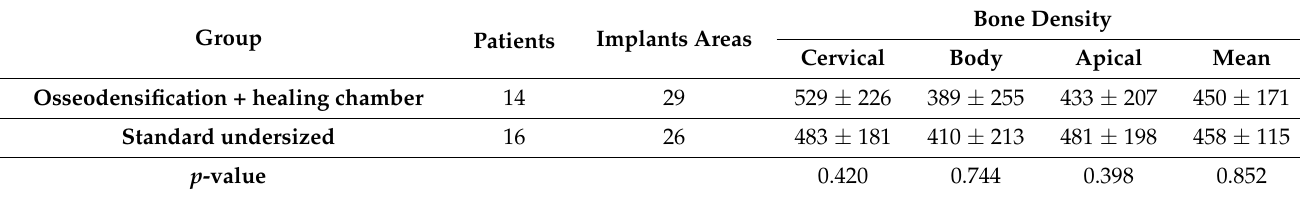
Table 3. The number of patients and implants in each group with respective mean bone density ( ± sd) at cervical, body, and apical regions of implantation